Question: Summarize what this figure shows in one sentence.
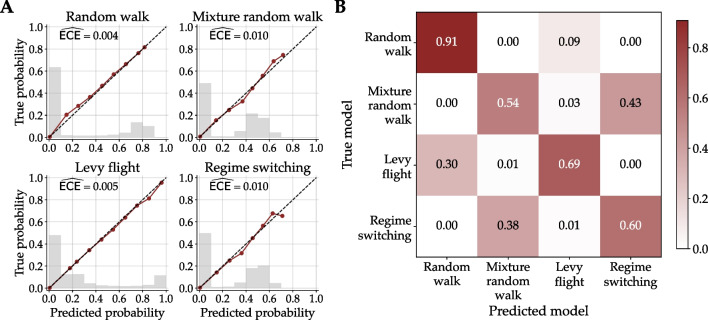
Answer: In silico model comparison and sensitivity results. A Calibration curves of all four NSDDMs aggregated across the neural approximator ensemble. Additionally, the expected calibration error ( \documentclass[12pt]{minimal} \usepackage{amsmath} \usepackage{wasysym} \usepackage{amsfonts} \usepackage{amssymb} \usepackage{amsbsy} \usepackage{mathrsfs} \usepackage{upgreek} \setlength{\oddsidemargin}{-69pt} \begin{document}$$\smash {\widehat{{\mathrm {{ECE}}}}}$$\end{document} ECE ^ ) is annotated within each subfigure. The gray histograms depict the relative frequencies of the predicted model probabilities. B Confusion matrix between true data generating model and predicted model. The proportion values were averaged across the ten neural approximators within the ensemble